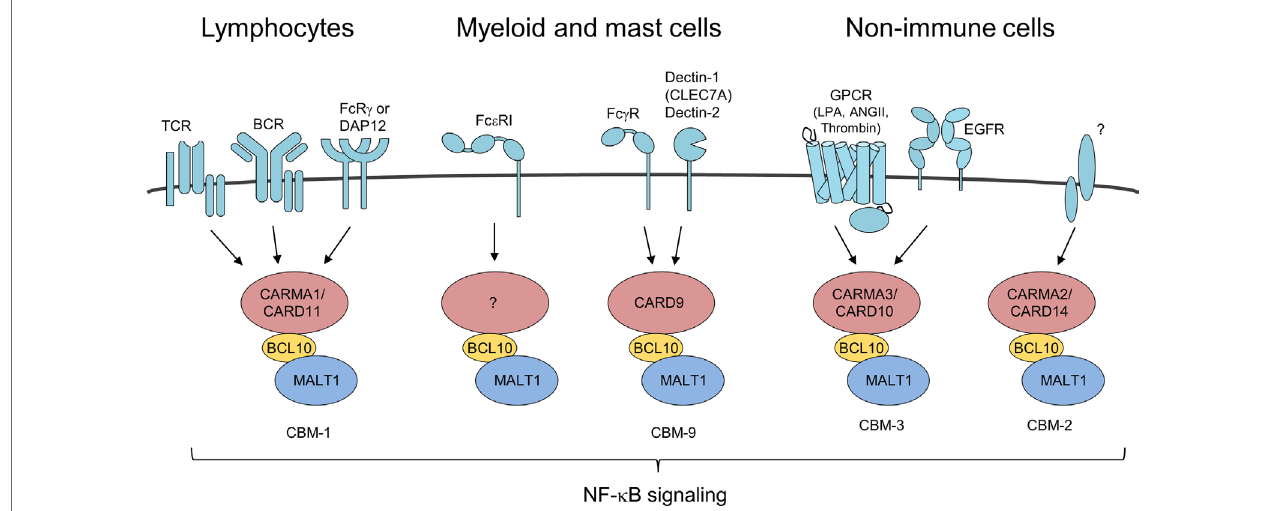
FiguRe 2 | Different CARMA/caspase-recruitment domains (CARDs) connect to B-cell lymphoma/leukemia 10 (BCL10)-mucosa-associated lymphoid tissue (MALT)1 in response to distinct upstream stimuli BCL10/MALT1 complex recruitment to different CARMA/CARD proteins is dependent on activation of various receptor types forming distinct CBM complexes. All signaling pathways converge upon formation of CBM complexes leading to I κ B kinase/NF- κ B and JNK activation